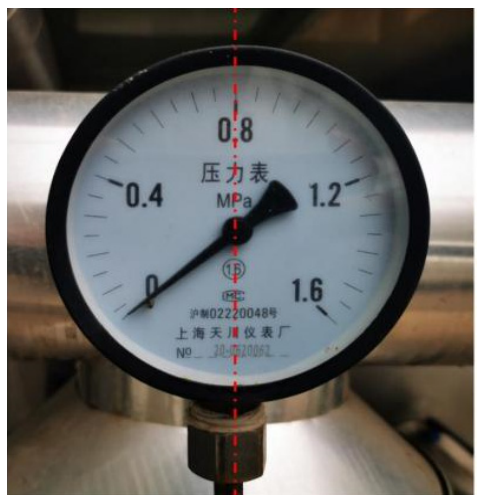
Figure 13. Medial axis diagram of pointer meter.